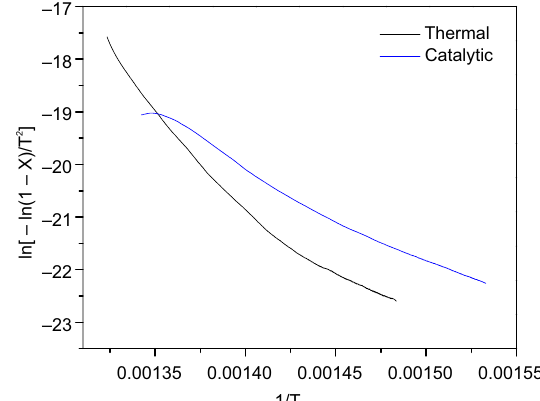
Figure 3. Kinetic plot for the thermal and catalytic degradation plastic sample